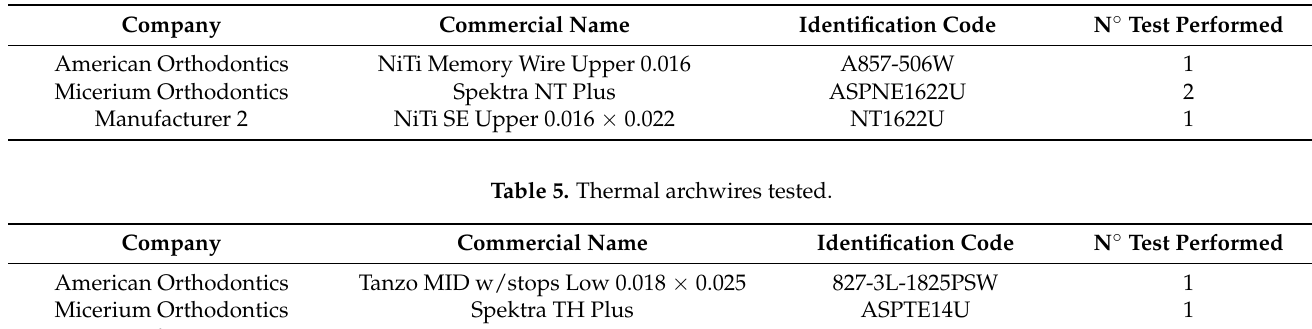
Table 4. Ni-Ti archwires tested.